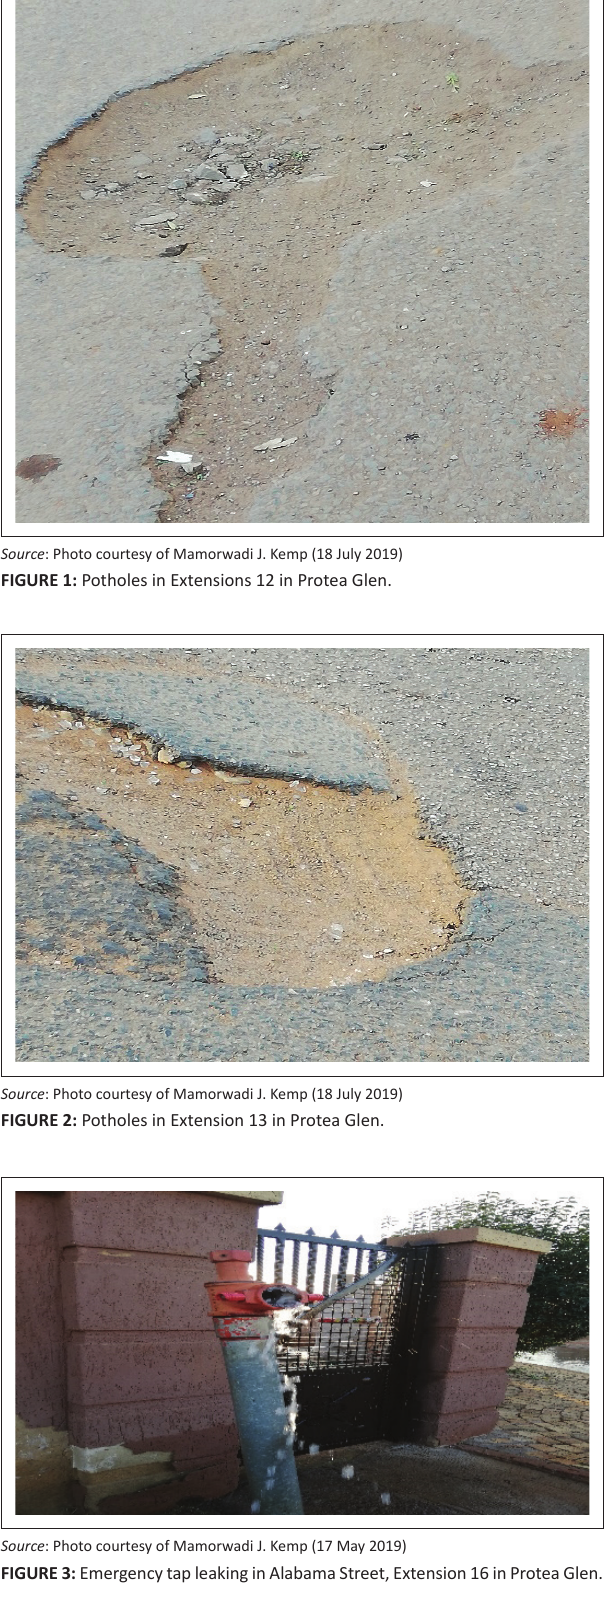
FIGURE 3: Emergency tap leaking in Alabama Street, Extension 16 in Protea